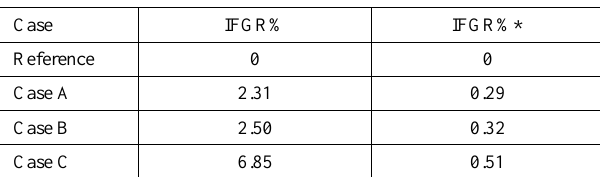
Table 4. The IFGR ratio